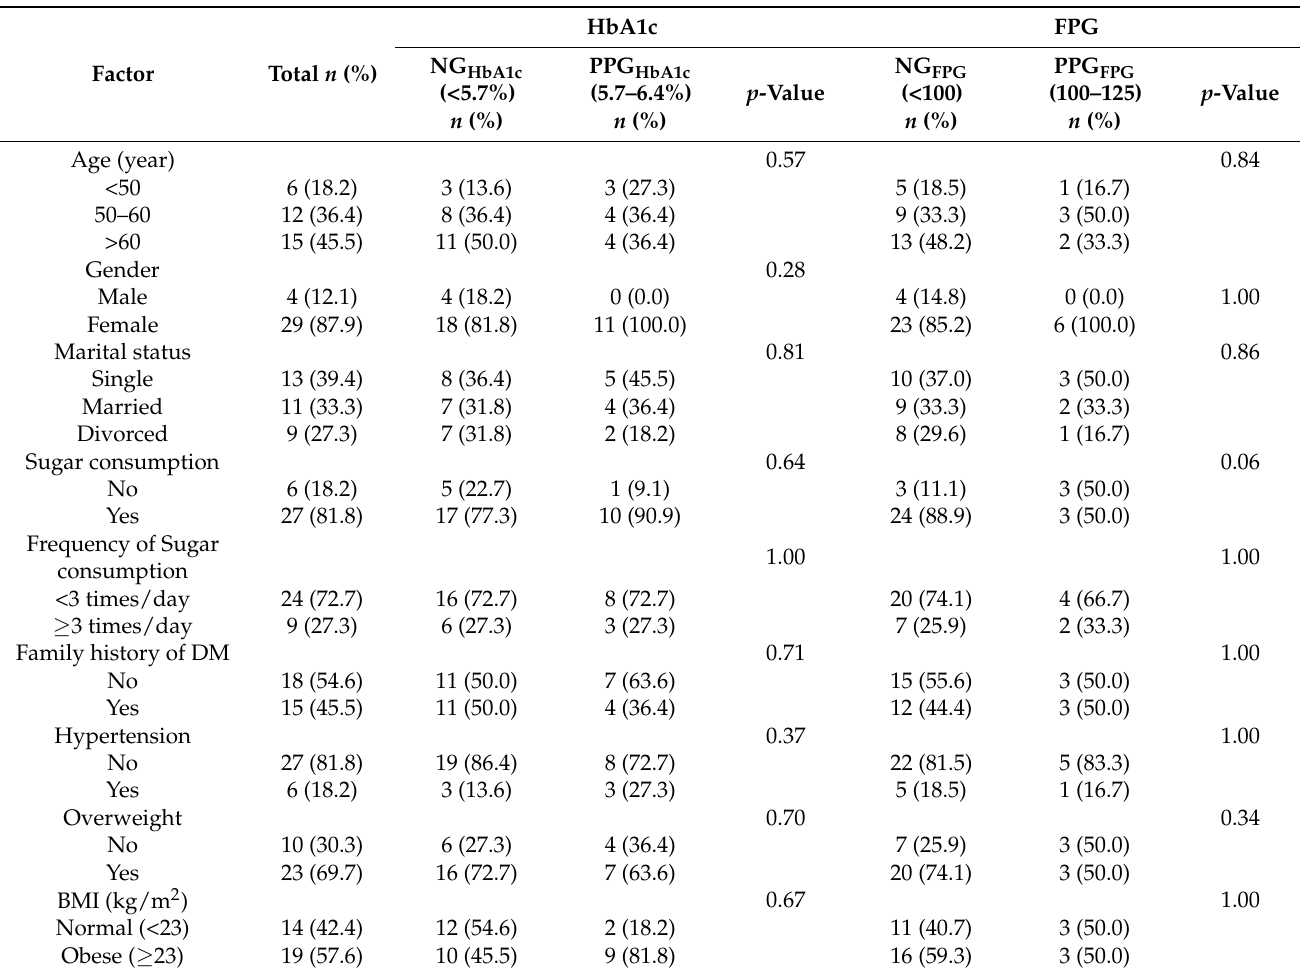
are not significantly different from those of the NG group. Table 1. Demographic and physical characteristics of 33 participants divided into NG and PPG groups according to either HbA1c or FPG levels.